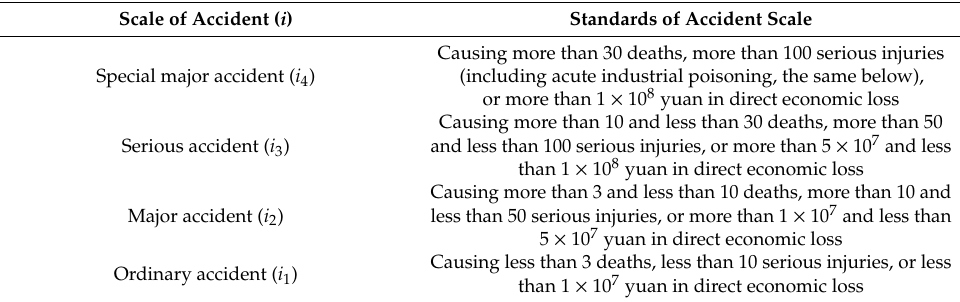
Table 1. Four scales and standards of accidents in